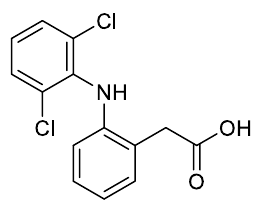
Figure 13. Structure of diclofenac.